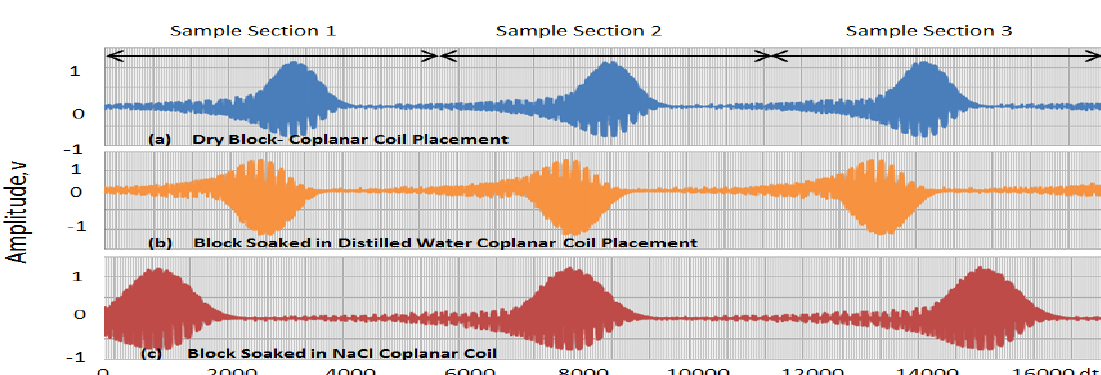
Table 3. Time difference for both configurations (coplanar and opposite).